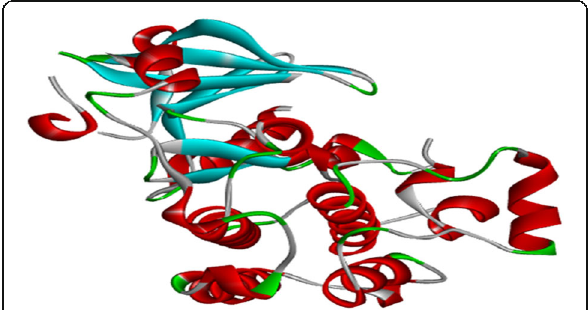
Fig. 1 Structure of the receptor,